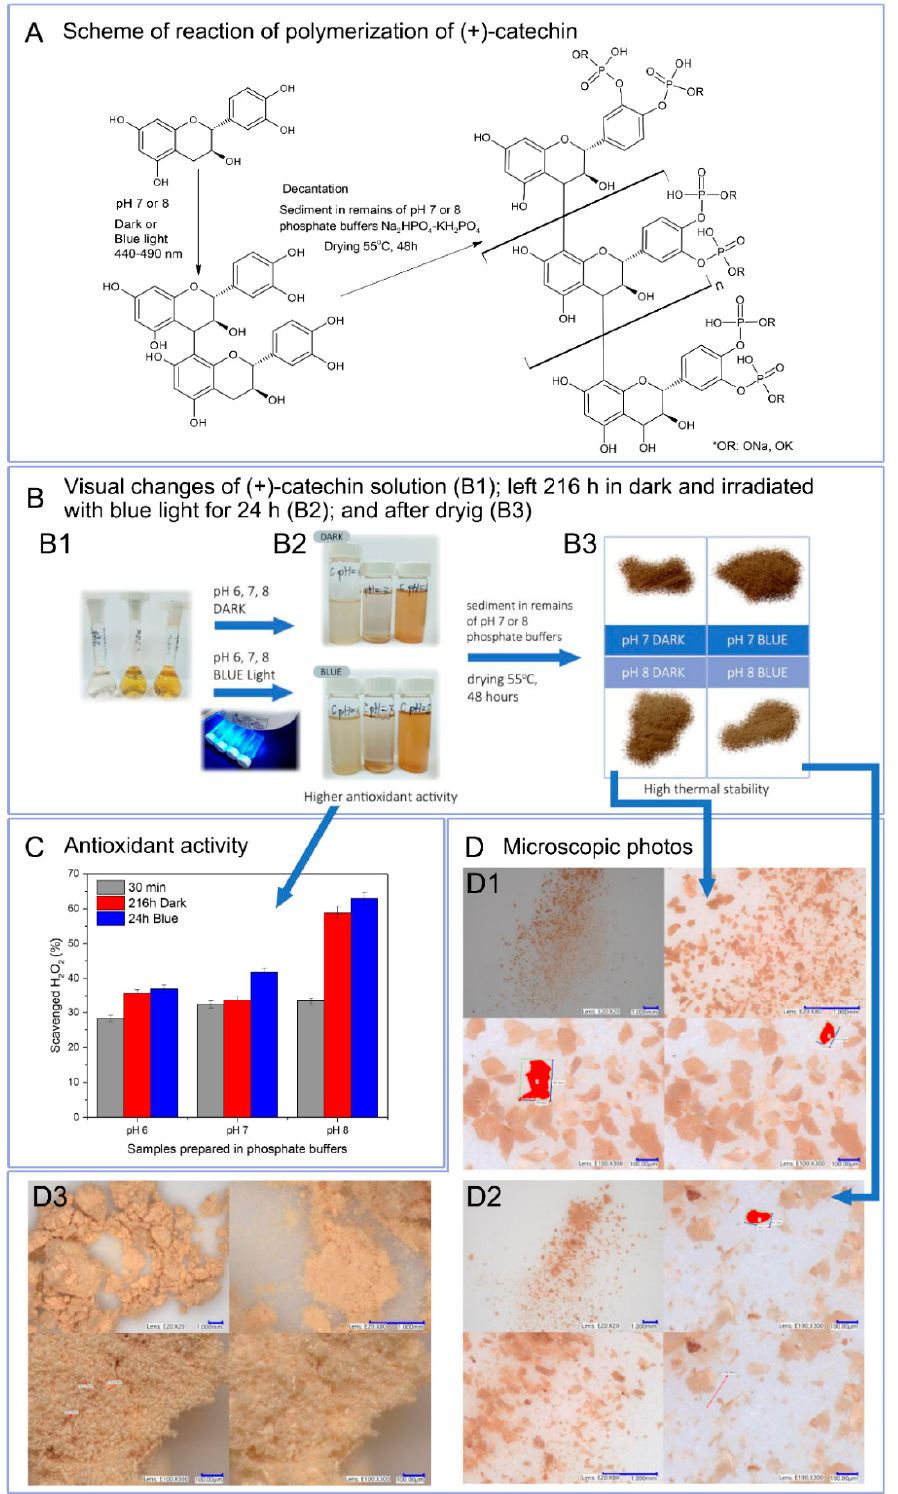
Figure 2. ( A ) Scheme of reaction of photopolymerization of ( + )-catechin. ( B ) Visual changes of ( + )-catechin solution after preparation ( B1 ); left 216 h in the dark and irradiated with blue light for 24 h ( B2 ); and after decantation of sediment and drying ( B3 ). ( C ) Antioxidant activity of catechin polymerization in phosphate bu ff ers in the dark for 216h and photopolymerization after irradiation with blue light for 24h in phosphate bu ff er at pH 6, 7, and 8. ( D ) Digital microscopic photos of powder of polymeric complex catechin compound obtained in pH 8 in the dark ( D1 ), compound obtained after blue irradiation ( D2 ), and reference ( + )-catechin ( D3 ).